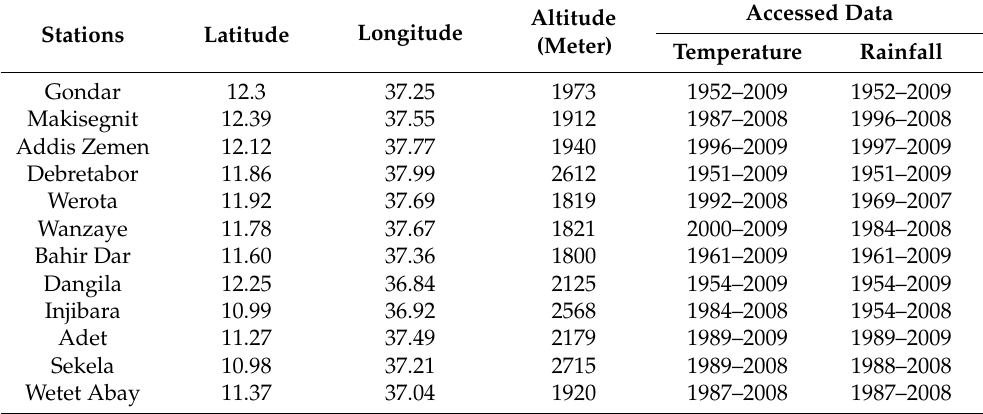
Table 1. The location, altitude and accessed climate variables of meteorological stations.